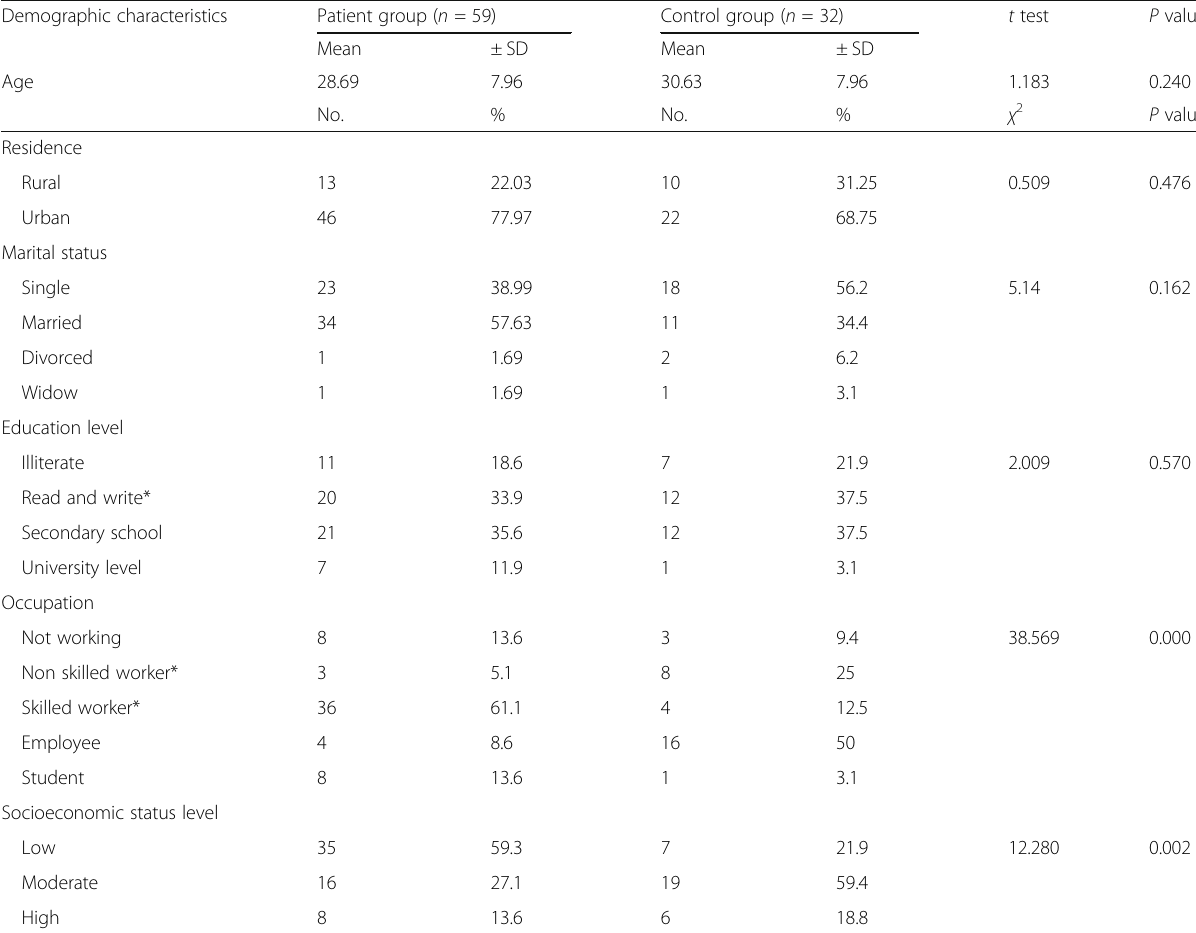
Table 1 Demographic characteristics of both studied groups Demographic characteristics